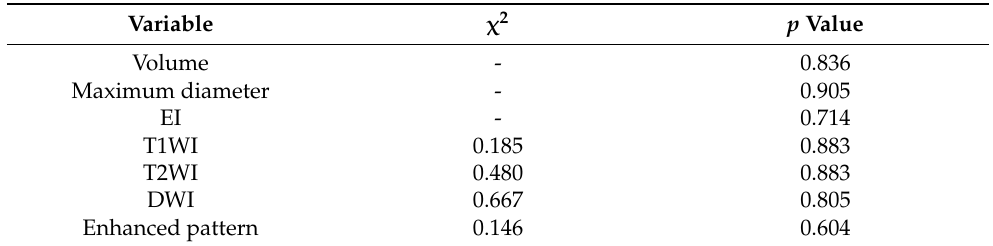
Univariate analysis of the response to HD-MTX rechallenge treatment with radiological